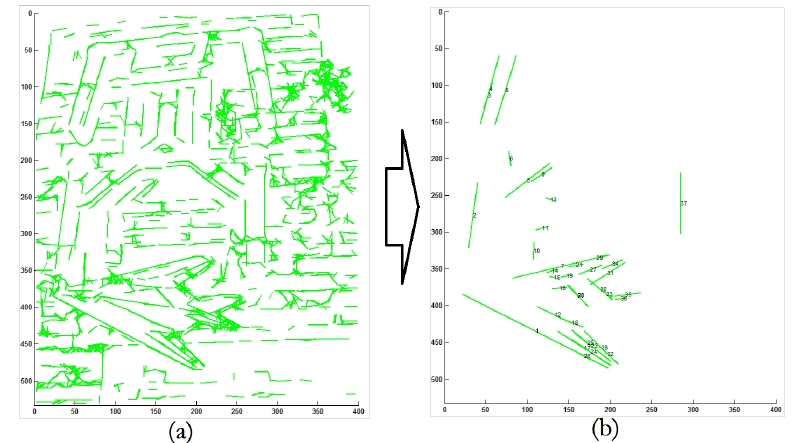
Figure 6. Example of line extraction by constraint propagation. For the image in ( a ), it is efficient to detect the the object satisfying the shape-based geometric constraints, as shown in ( b